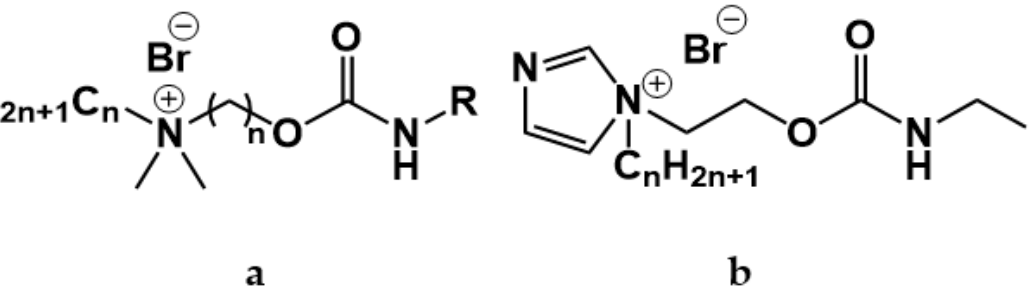
Figure 1. Chemical formulas of carbamate-containing amphiphiles bearing ammonium ( a ) and imidazolium ( b ) moieties.